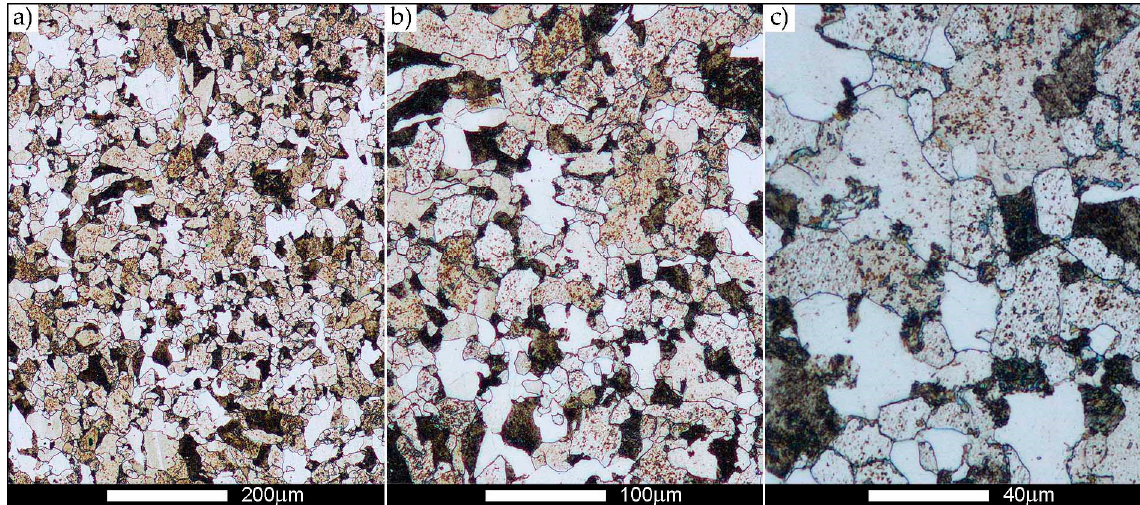
Figure 25. Welded joint microstructure of Hardox 450 steel with revealed grain boundaries of prior austenite, austenitised at 1000 °C—BM zone shown in Figure 2. ( a ) 100×; ( b ) 200×; ( c ) 500×.